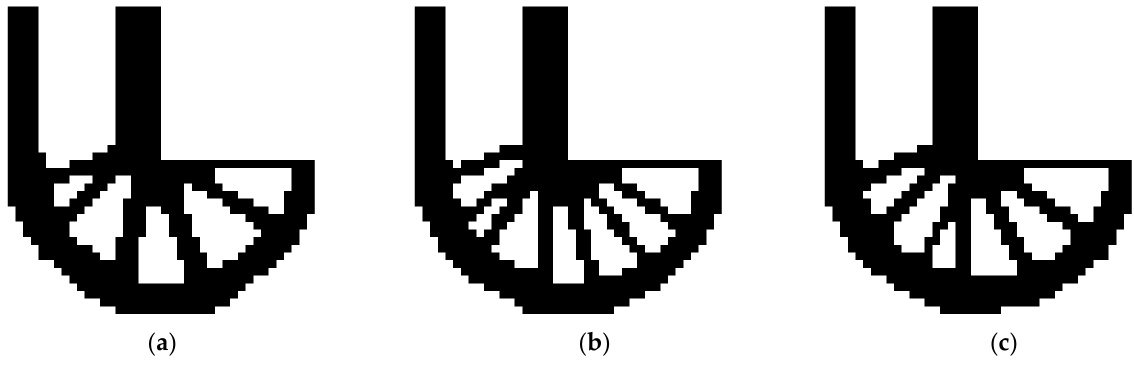
Figure 8. Topological configurations obtained by the two algorithms. ( a ) C = 37.8189, t = 25. ( b ) C = 37.7605, t = 27. ( c ) C = 37.9437, t = 27.